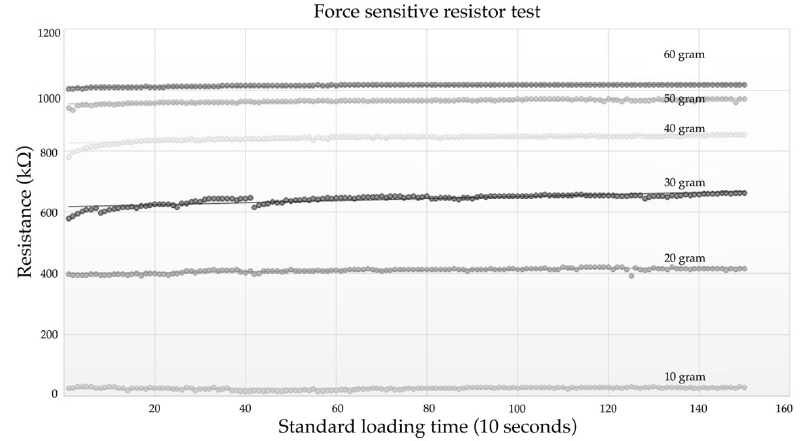
Figure 16. Resistance and standard loading time.